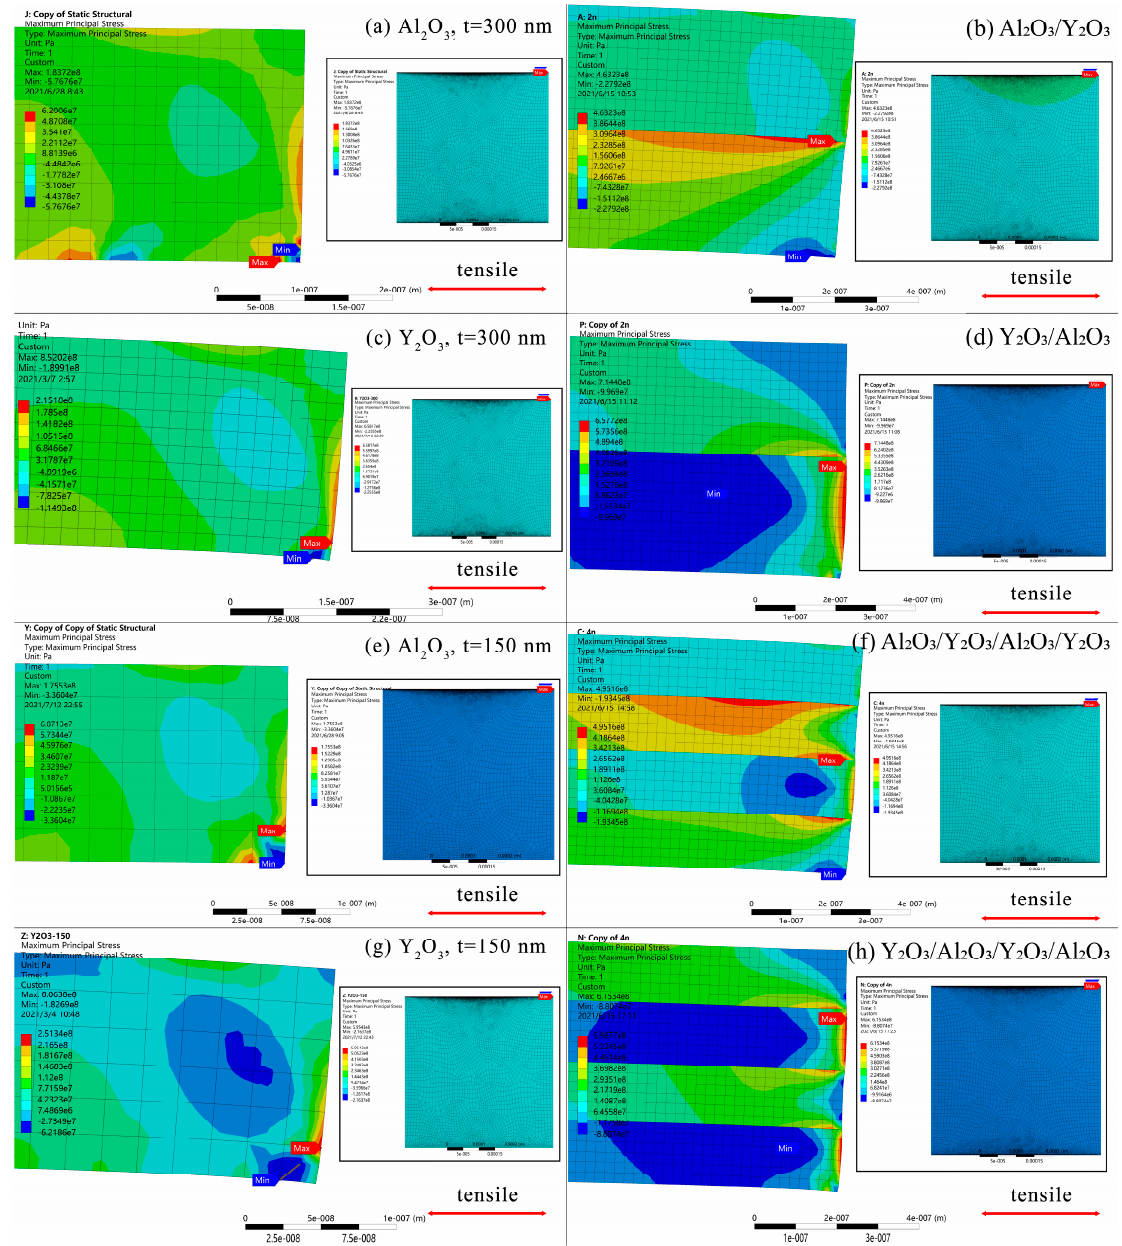
Figure 6. Comparison of the max principal stress in laminated coatings and single-layer coatings: ( a ) Al 2 O 3 , t = 300 nm; ( b ) Al 2 O 3 /Y 2 O 3 ; ( c ) Y 2 O 3 , t = 300 nm; ( d ) Y 2 O 3 /Al 2 O 3 ; ( e ) Al 2 O 3 , t = 150 nm; ( f ) Al 2 O 3 /Y 2 O 3 /Al 2 O 3 /Y 2 O 3 ; ( g ) Y 2 O 3 , t = 150 nm; ( h ) Y 2 O 3 /Al 2 O 3 /Y 2 O 3 /Al 2 O 3 . The decrease of max principal stress in the laminated coating series 2 (with Al 2 O 3 top coat) as the layer thickness decreases can be explained by the stress singularity theory. At the edge of the interface, where there is a sudden change of stiffness, exists a stress